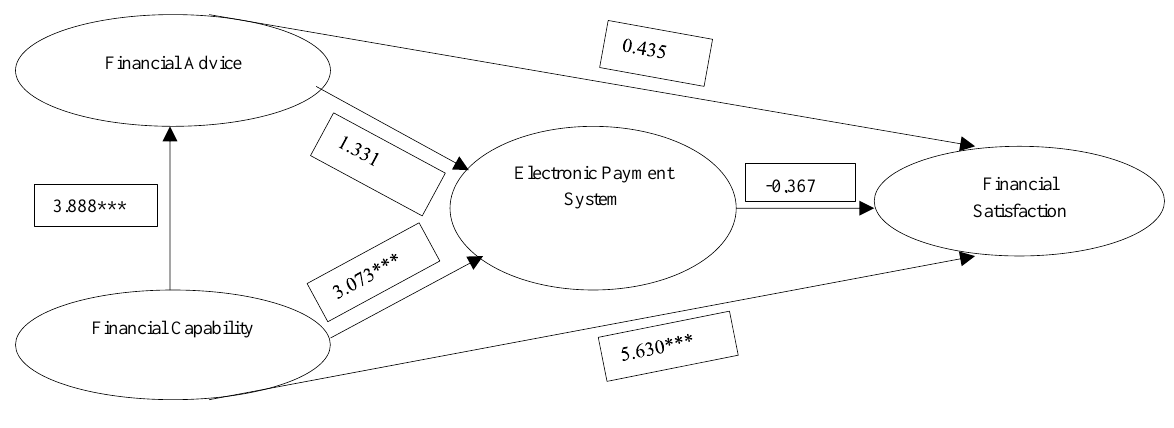
Figure 2: The Final